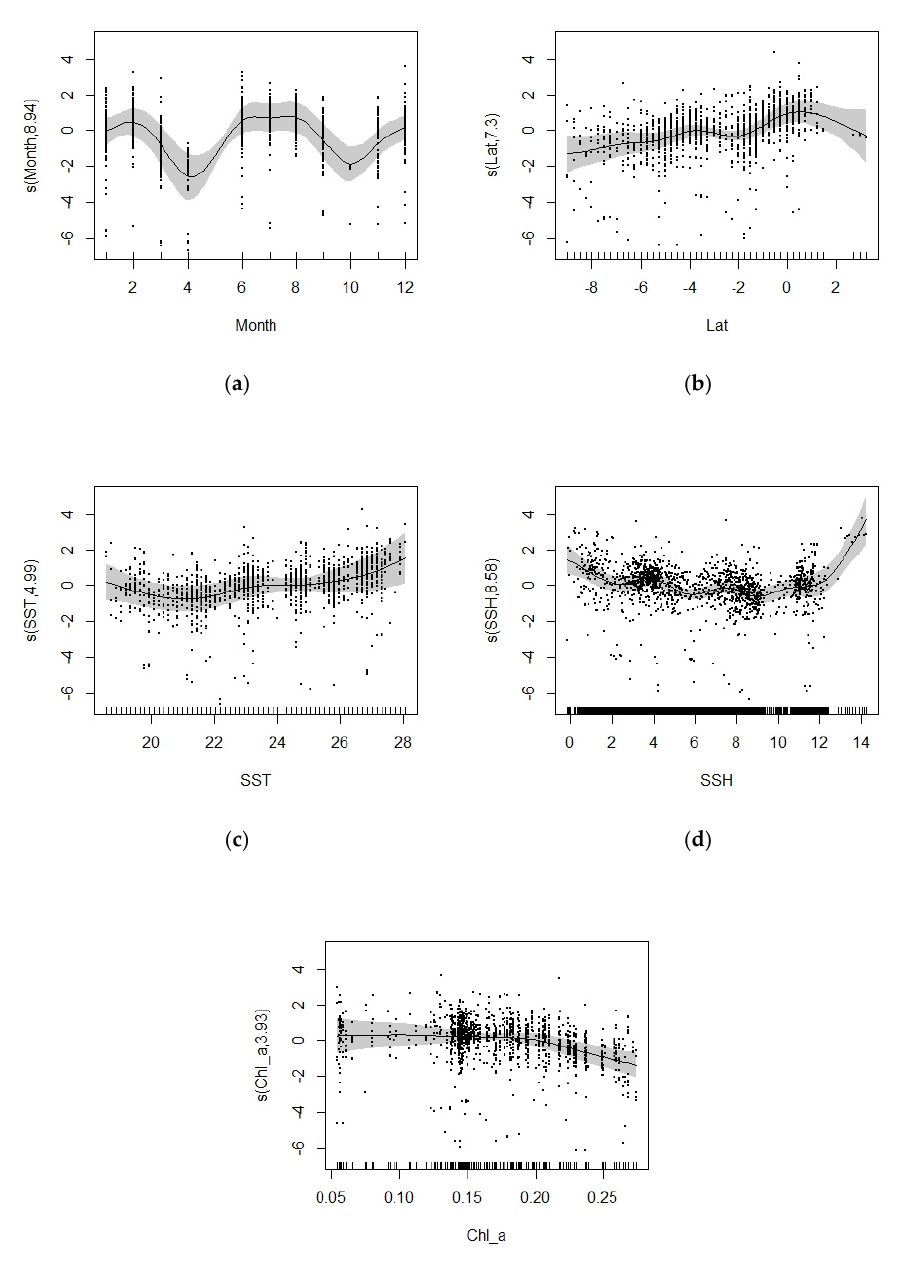
Figure 6. Effects of impact factors on the jumbo flying squid Dosidicus gigas CPUE derived from the GAM analysis in the equatorial waters of the eastern Pacific Ocean: ( a ) month; ( b ) latitude; ( c ) SST; ( d ) Chl_a; ( e ) SSH.